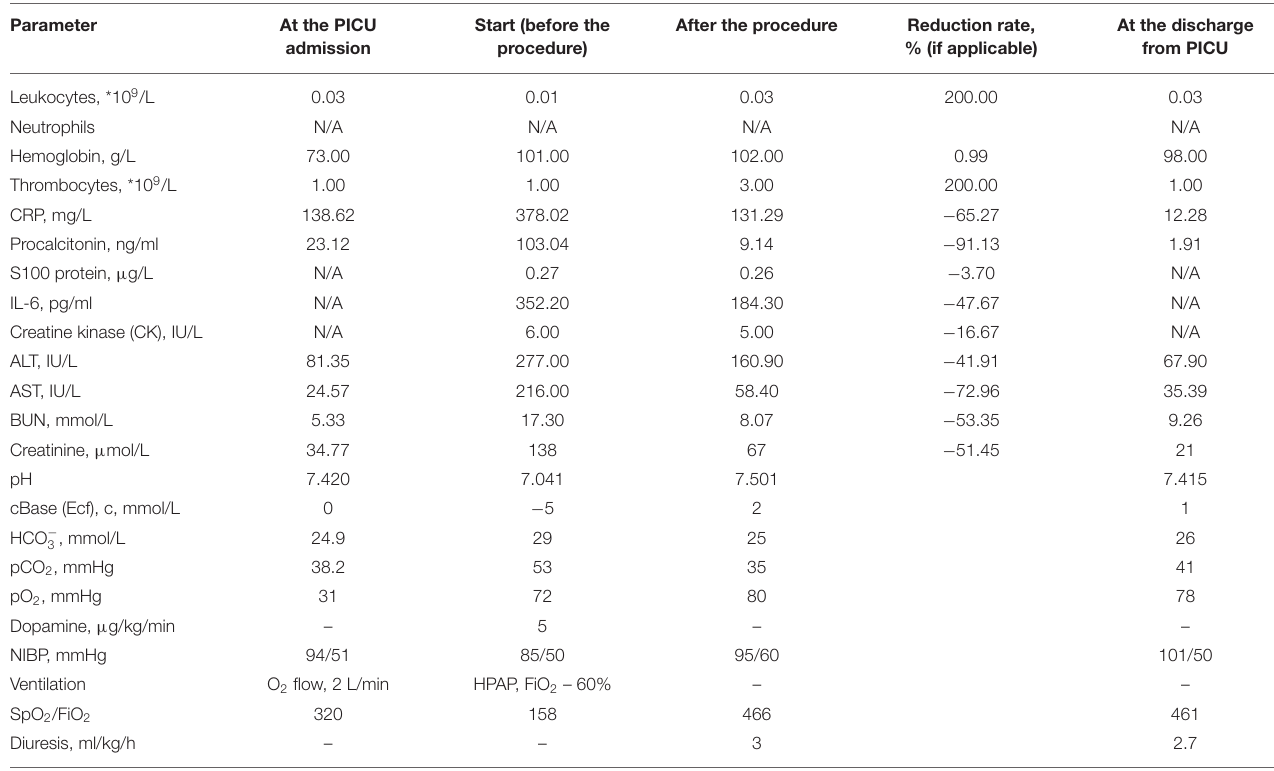
TABLE 2 | Main clinical and laboratory parameters (patient 2).